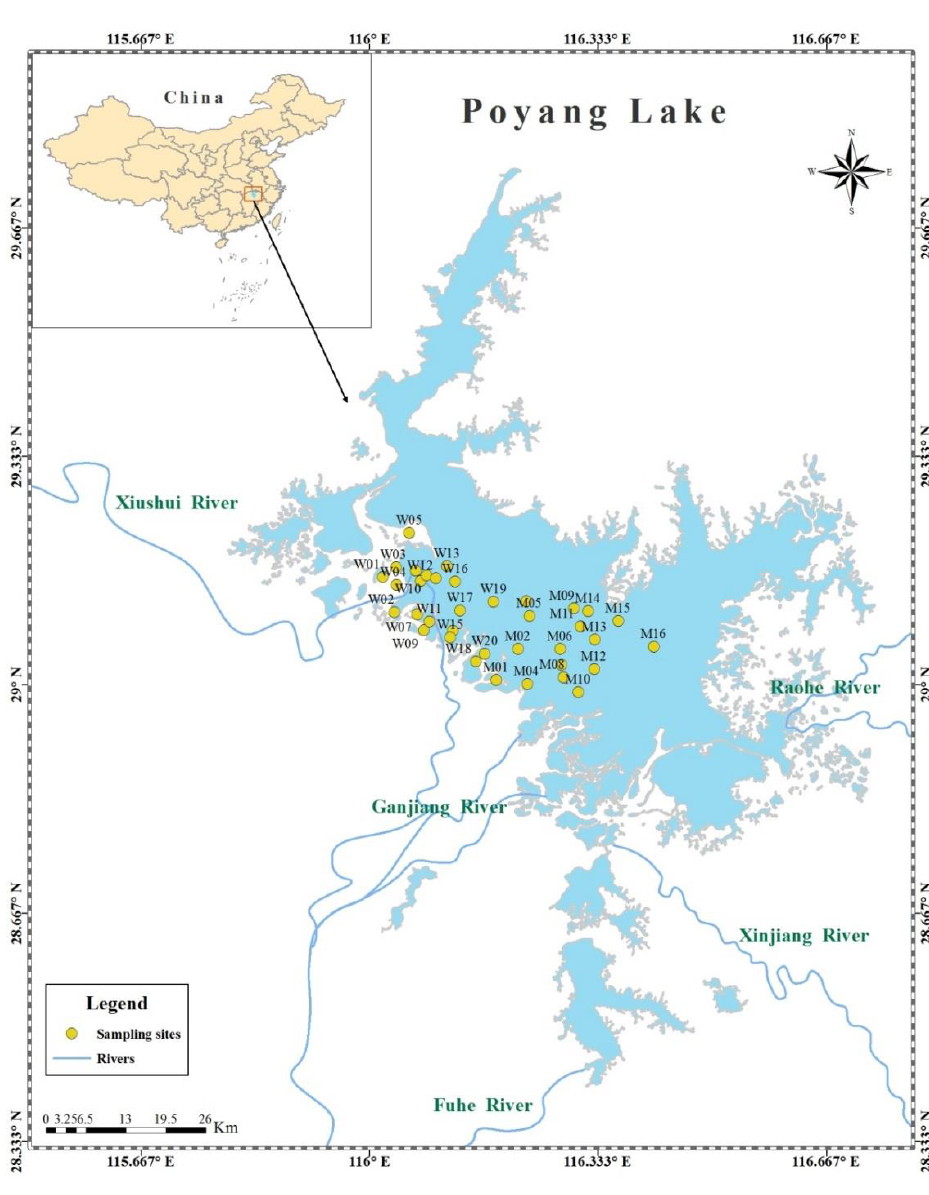
Figure 1. Sampling sites in Poyang Lake, China.